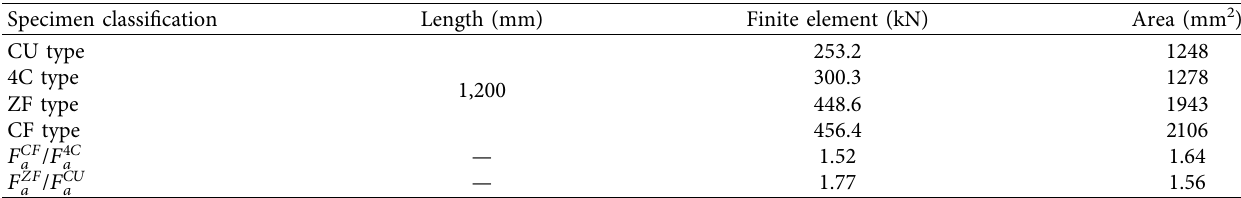
Table 5: Comparison of the finite element between built-up and profiled steel